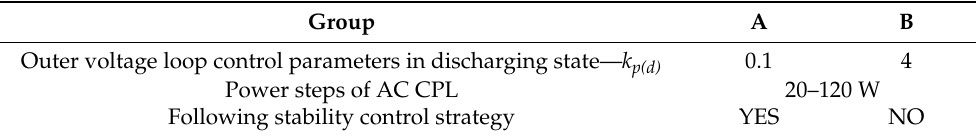
Table 4. Experimental platform parameters for groups A and B in the discharged